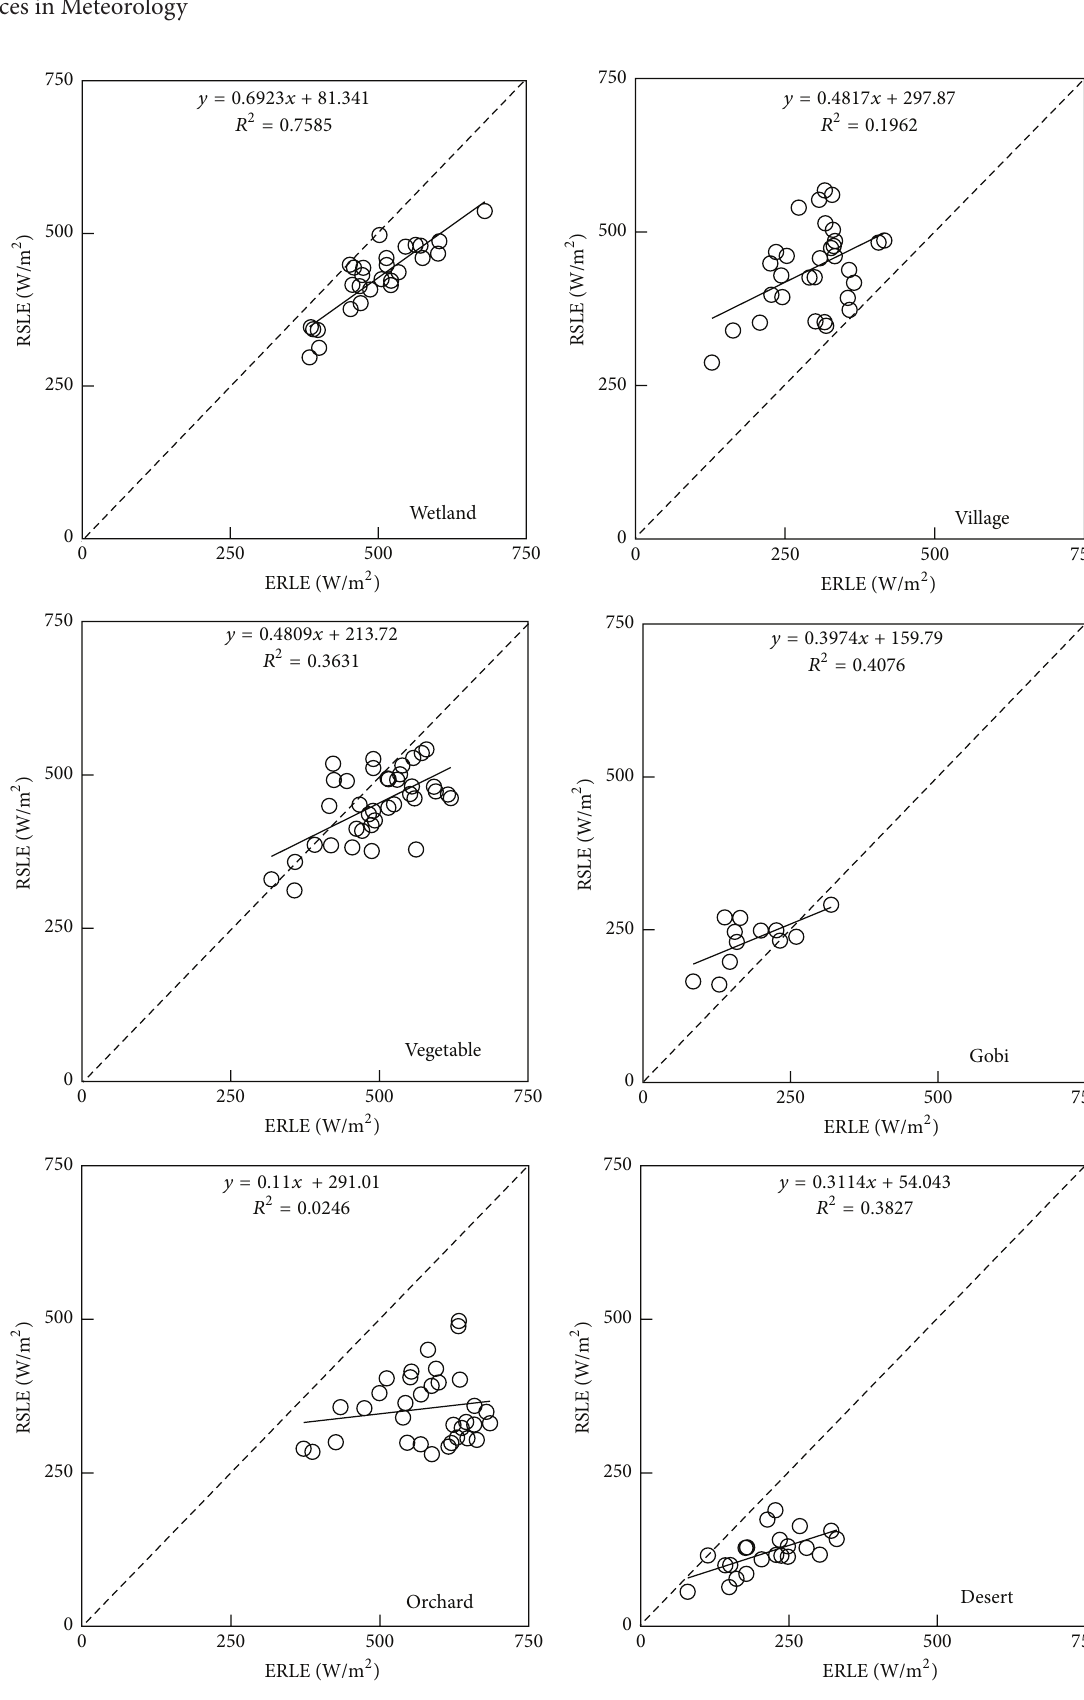
Figure 5: Comparisons between ERLE and RSLE at 6